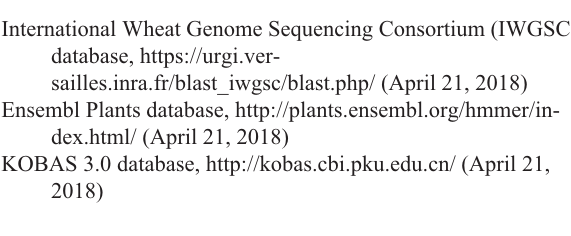
Table S1 - SNPs and candidate genes significantly associ- ated with Total spikelet number per spike (TSS)